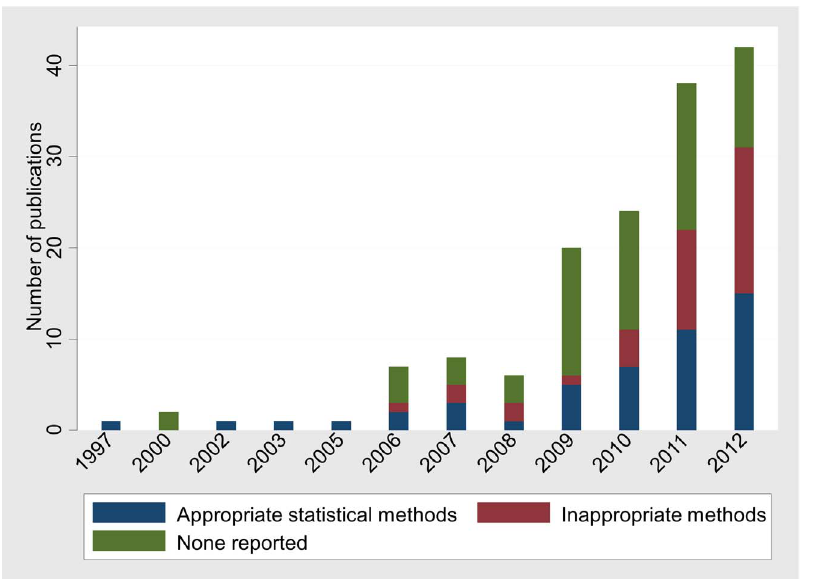
Figure 5. Number of published full networks by year (1997–2012) and the method employed to examine inconsistency. Appropriate statistical methods are presented in Table 2. Networks that used more than one method are included in all relevant